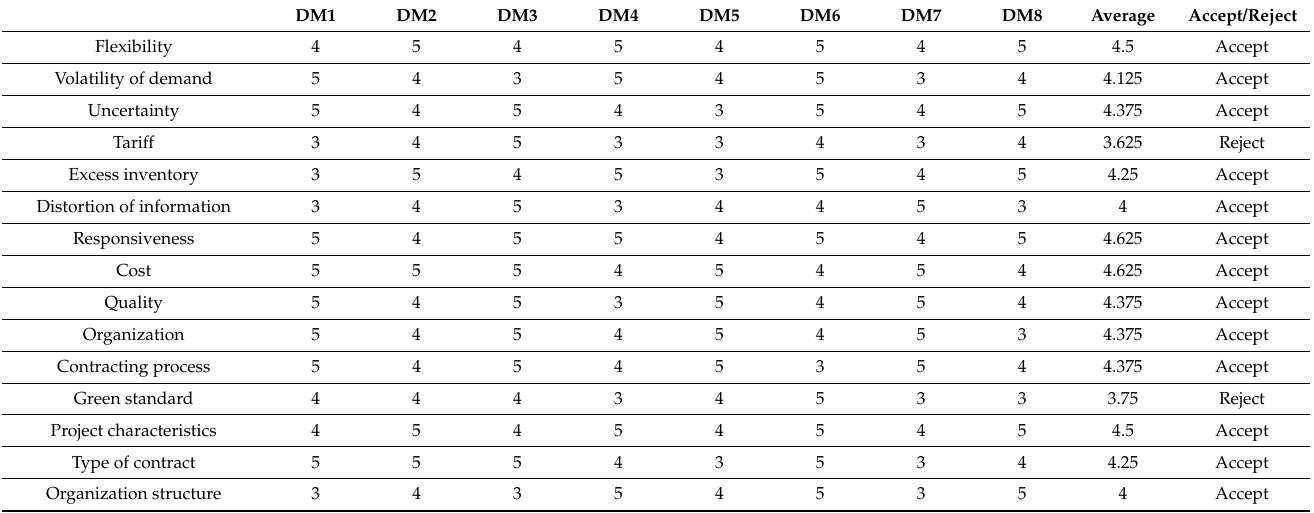
Table 4. Results of customized factors.